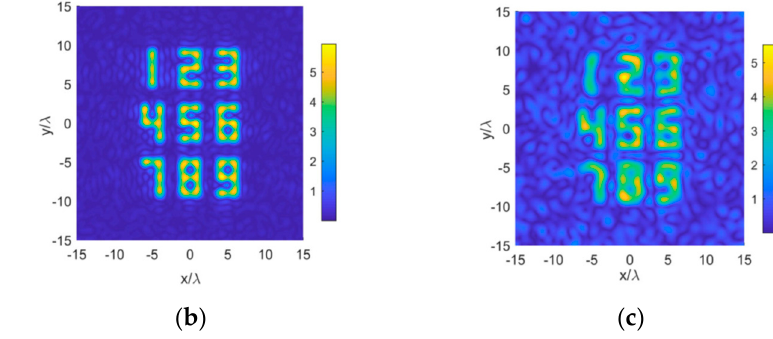
Figure 13. The propagation modes in the sampling plane (red grids).